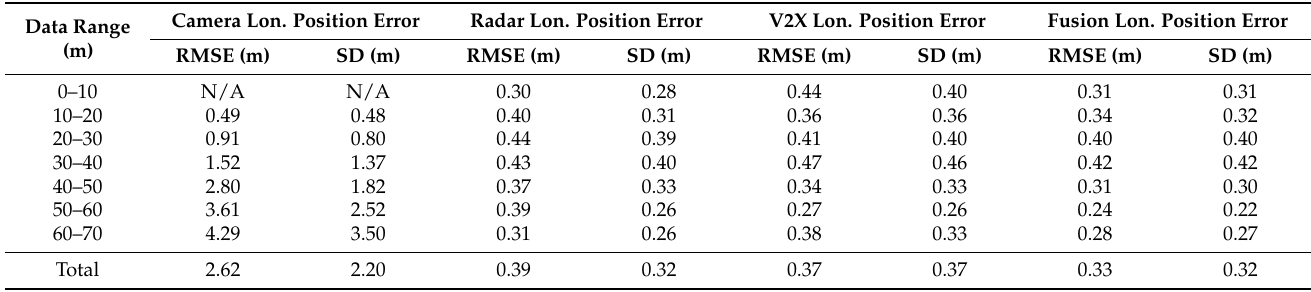
Table 9. Relative positioning accuracy in the longitudinal direction for the measurements obtained during the normal driving scenario 2. Camera Lon. Position Error Data Range (m)